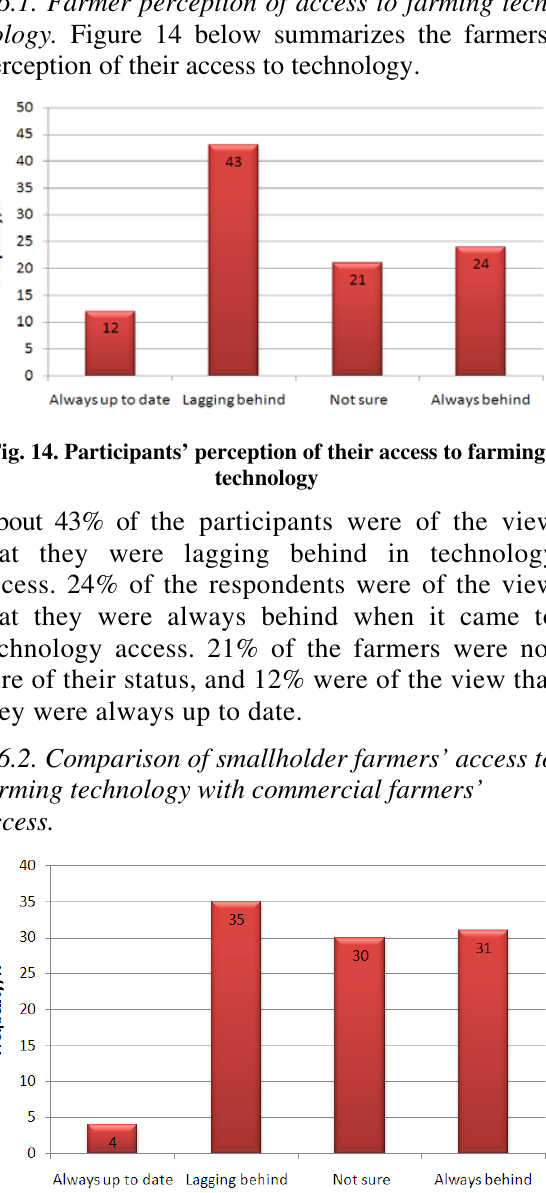
Fig. 15. Comparison of smallholder and commercial far- mers’ access to